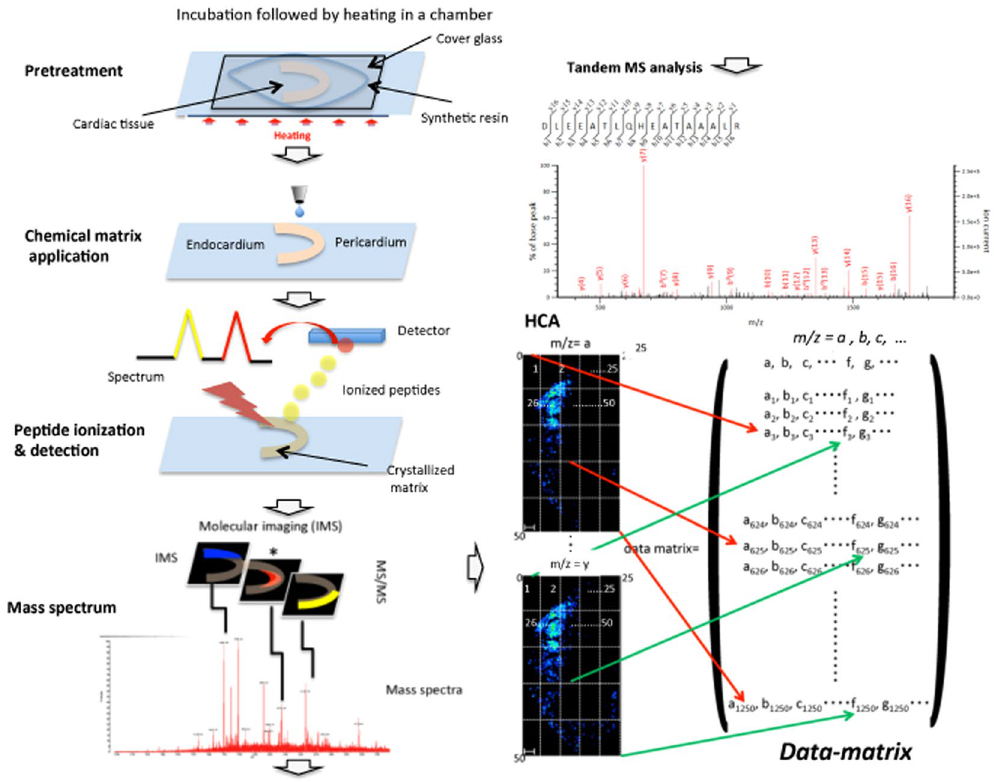
Figure 1. MALDI-Imaging mass spectrometry: experimental flowchart. Cardiac tissue samples were digested using trypsin in a chamber at 37 °C, and then were boiled at 95 °C in a reaction buffer developed in our lab. Following matrix (2,5-dihydroxybenzoic acid) deposition, a laser was used to ionize the peptides and an electric field was applied until they reached the detector. The ionized peptides were separated based on mass-to-charge ratio ( m/z ) values and the spectrum revealed the two-dimensional distribution of the peptides in tissues. Mass spectra were generated in an ordered array in the x-y coordinate space. Individual spectral features were visualised within the tissue to generate protein images. Histological features within the sample were correlated with molecular species. MS/MS analysis identified proteins that corresponded to individual spectra. For example, the lateral and axial resolution of an image is 25 × 50 pixels. The intensity of every pixel is measured for each m/z value. The MDM obtained from this dataset is shown in the right bottom panel. In this MDM, the row represents individual m/z values ( a, b, c … ); the columns indicate the m/z peak values of all 1250 pixels ( m/ z j ;1 ≤ j ≤ 1250).